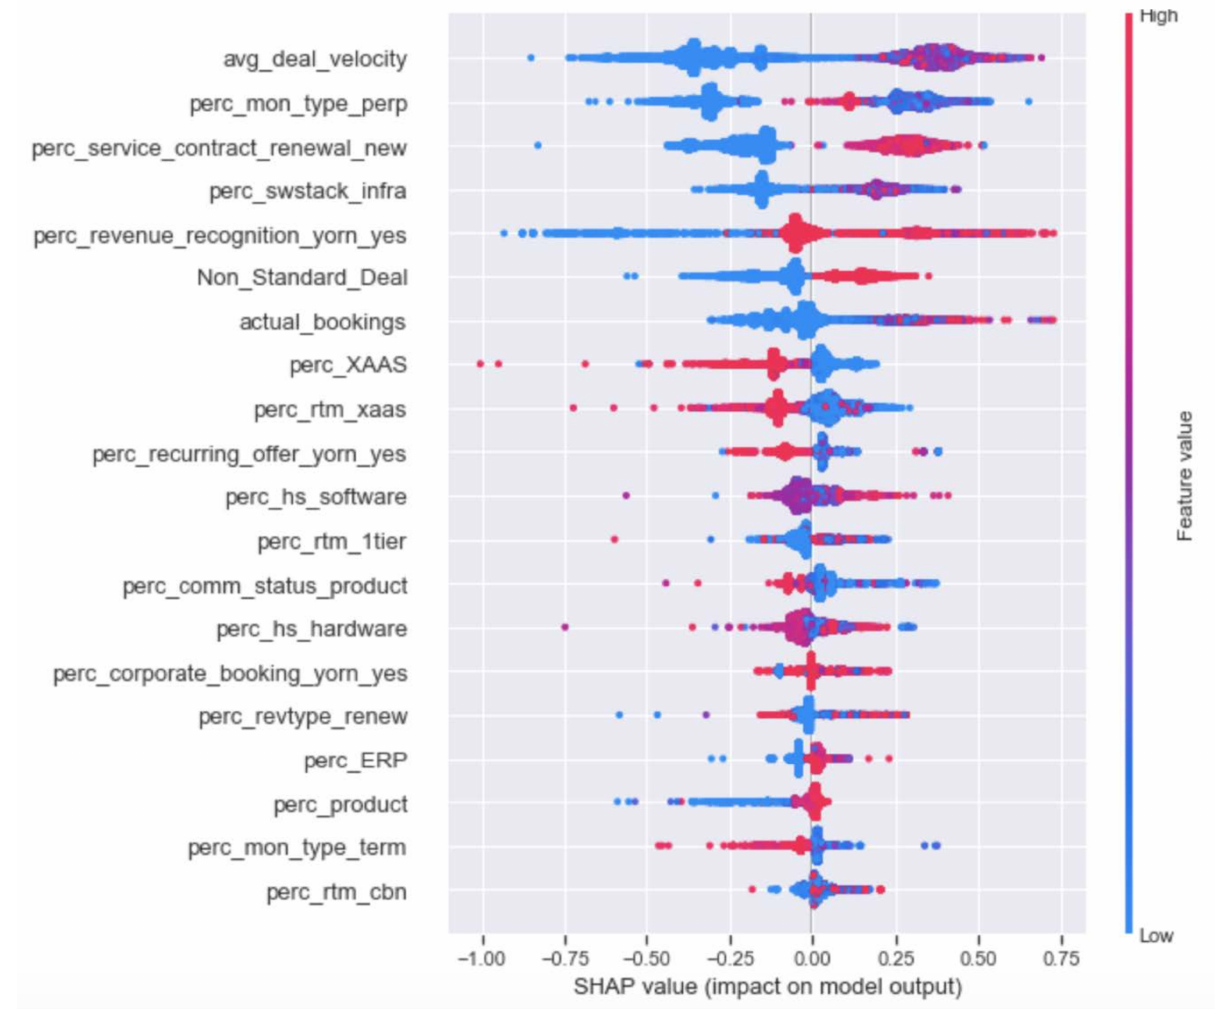
Figure 2. SHAP (Shapley Additive explanations) of feature importance